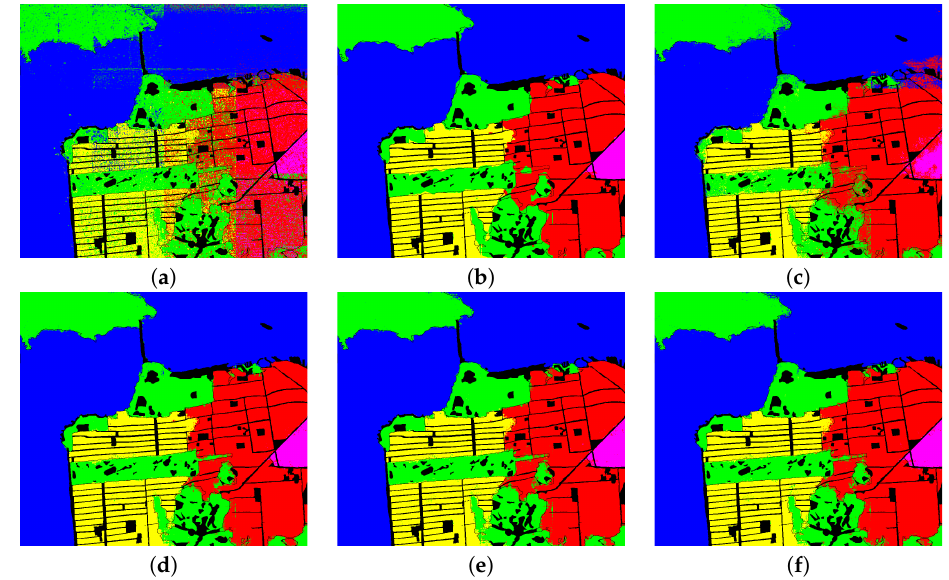
Figure 18. Classification maps resulting from the San Francisco data set with different algorithms.